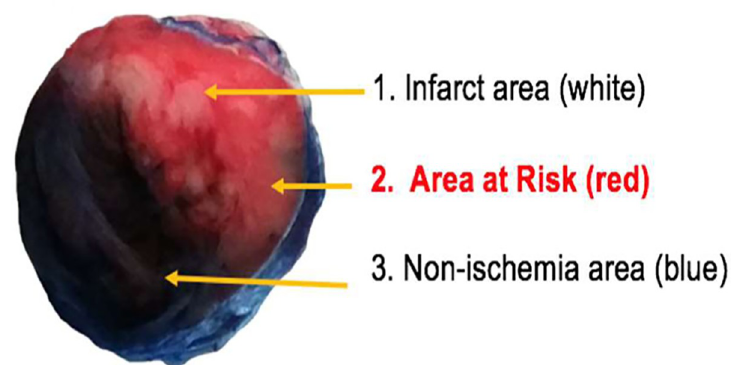
Fig 3. Evans blue and 2,3,5-triphenyltetrazolium chloride (TTC) staining. Evans blue and TTC staining determined infarct area (1, white), area at risk (2, red), and non-ischemic area (3,